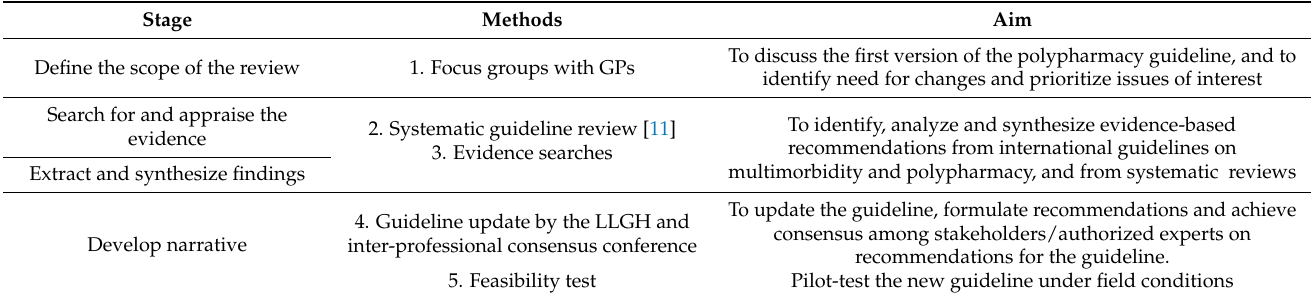
Table 1. Stages and methods of the realist